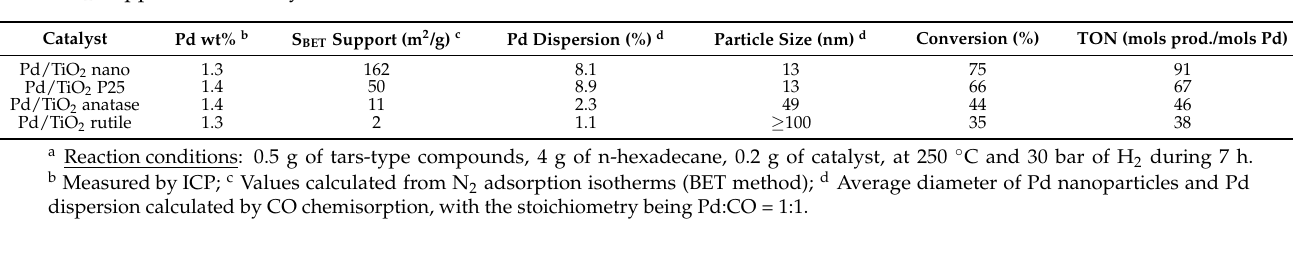
Table 2. Main textural, physico-chemical properties and catalytic performance in tars mild hydrotreatment for different TiO 2 -supported Pd catalysts a .